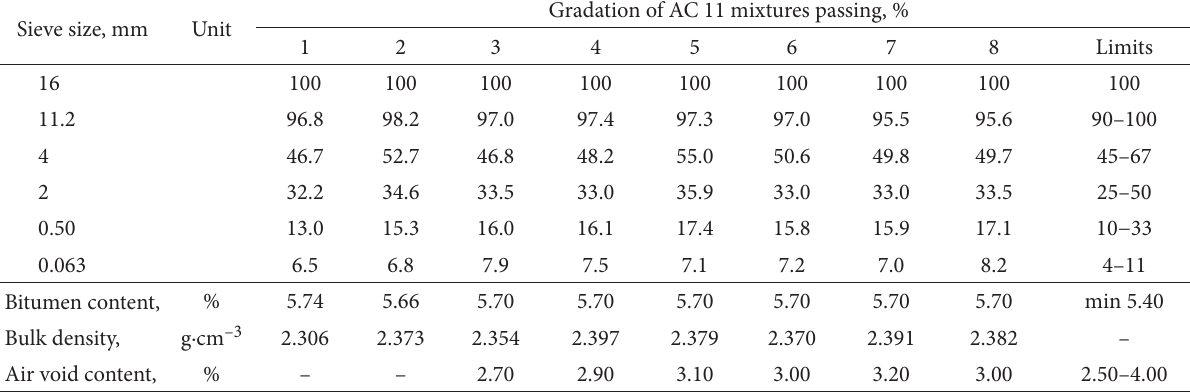
Table 2. Aggregate gradation and asphalt content of tested mixtures Sieve size, mm